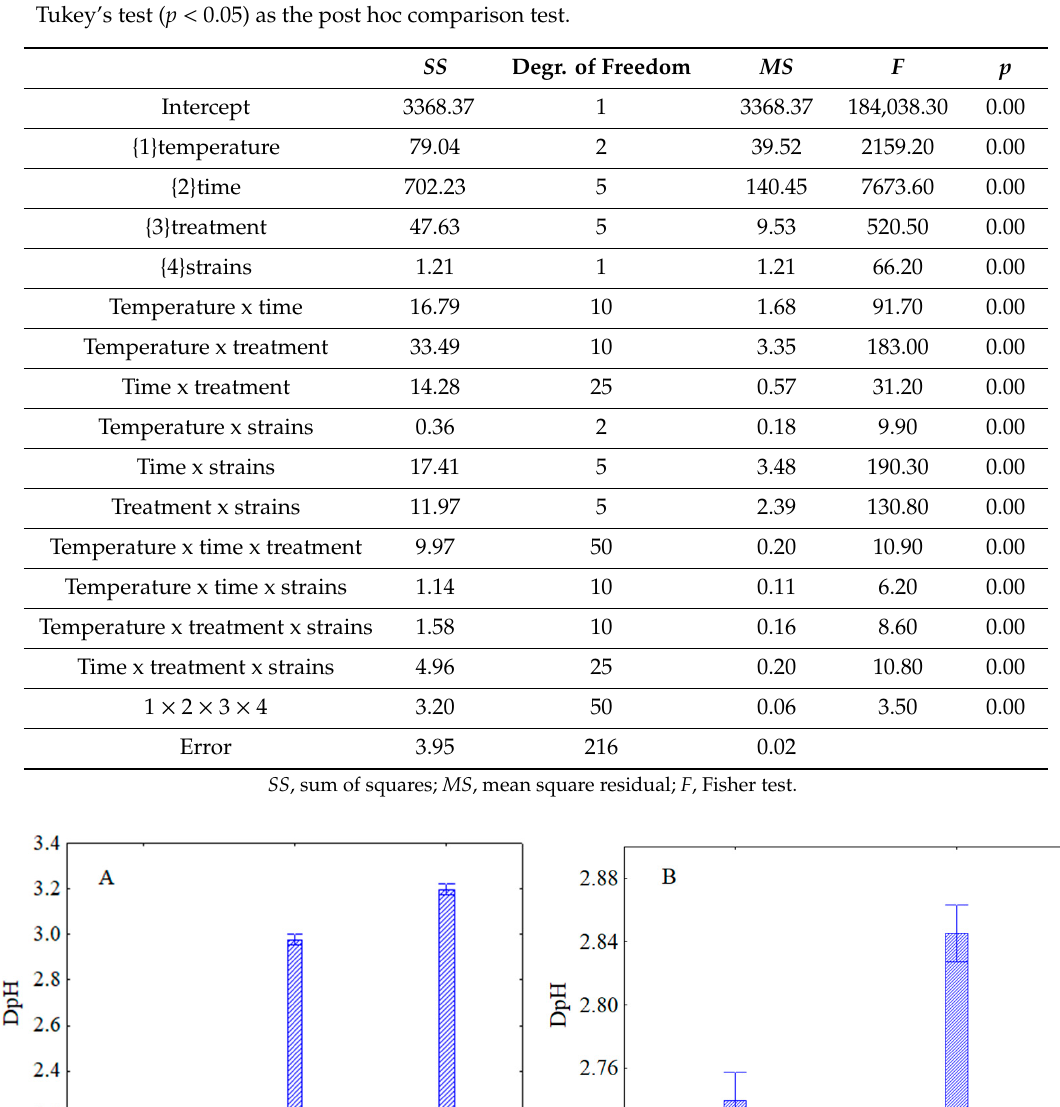
Figure 7. Decomposition of the statistical hypothesis for the interaction of the temperature vs strains ( A ) and vs treatments ( B ) on acidification. Bars denote 95% confidence intervals. Experiment on the effect of a thermal abuse in rice beverage for L. plantarum c16 and c19. For the code of US treatments see Table 2. Finally, Figure 8 (temperature–time–treatment interaction) points out that the best condition to delay acidification was in correspondence to treatment A at 4 °C for both strains c16 and c19. In fact, DpH values were clearly lower than all other treatments; for example, compared to its control (B treatment), which had a DpH ranging from 0 to 3, treatment A showed a DpH of 0–1.5, while acidification occurred in experiments C and E (attenuated strains in beverages stored under a thermal abuse) without differences to their controls (samples D and F).